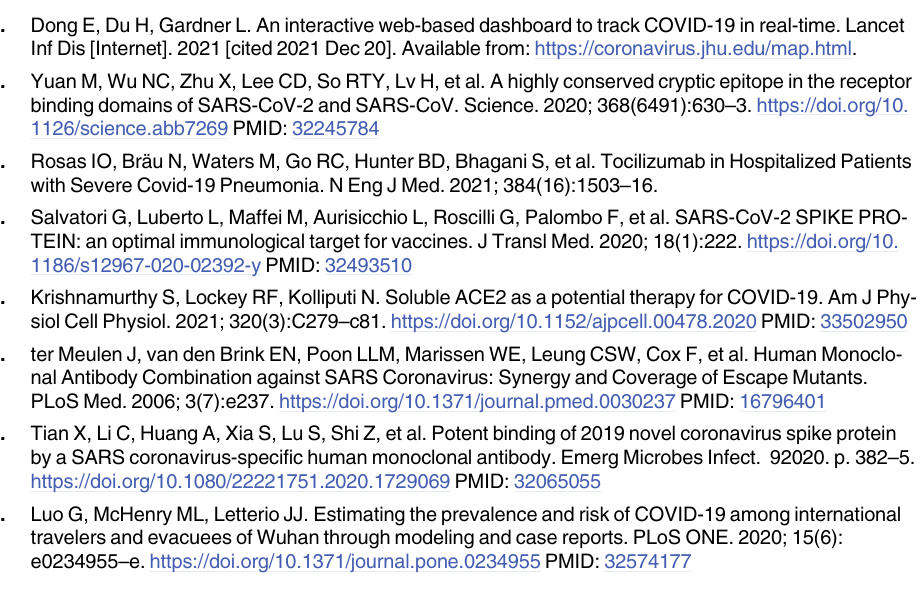
S1 Table. Codon usage table for Aurantiochytrium acetophilum